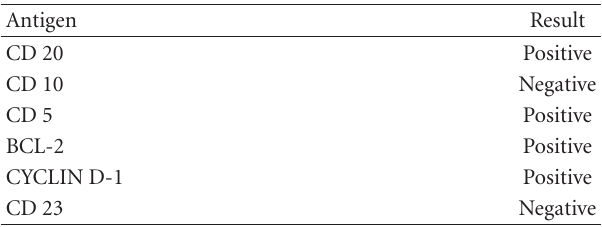
Table 1: Immunohistochemical staining results.